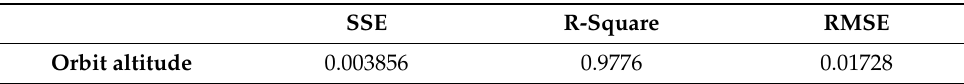
Figure 5. Curve fitting of stellar trajectory. ( a ) The fitting results of smoothing spline method. ( b ) The distribution of the fitting errors. Table 2. Analysis of fitting